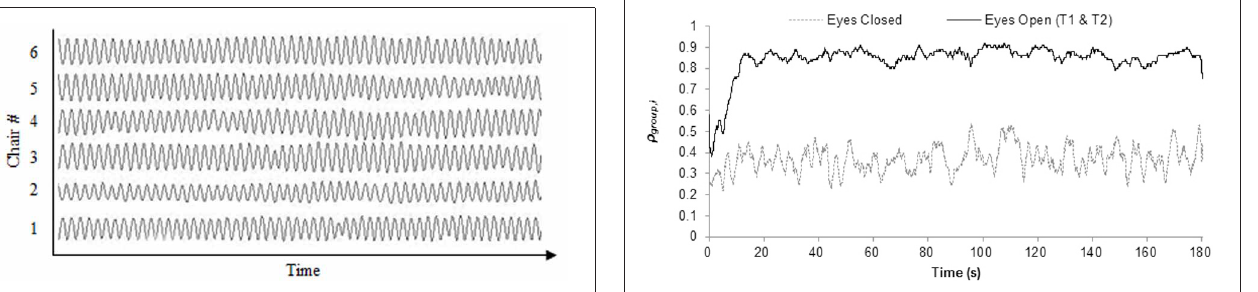
FIGURE 1 | Example time-series of the rocking chairs’ z-direction (up-down) movements over time.